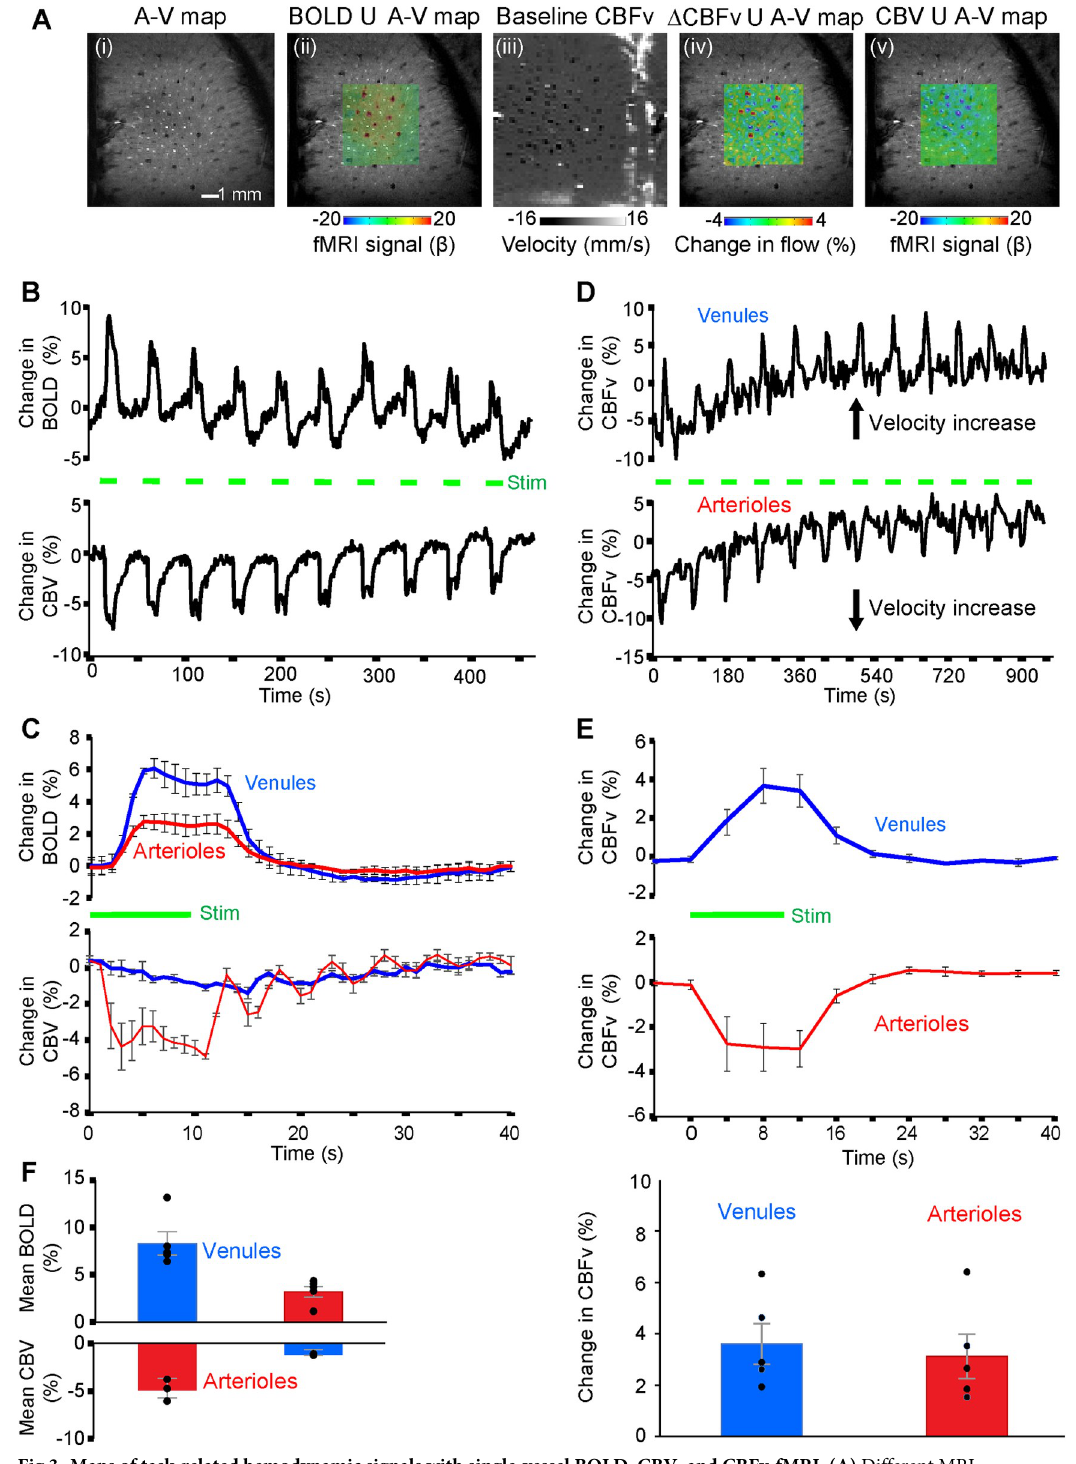
Fig 3. Maps of task-related hemodynamic signals with single-vessel BOLD, CBV, and CBFv-fMRI. (A) Different MRI measurement strategies on the same 2D slice. From left to right: (i) the A–V map defines arterioles as bright dots and venules as dark dots; (ii) the evoked bSSFP-based BOLD fMRI map, within a green subregion, on top of the A–V map; (iii) the PC-MRI map of baseline CBFv; (iv) the CBFv-fMRI map on top of the A–V map with an increased flow velocity corresponding to brighter voxels for venules and darker voxels for arterioles; and (v) evoked bSSFP-based CBV-fMRI map on top of the A–V map. (B) The time